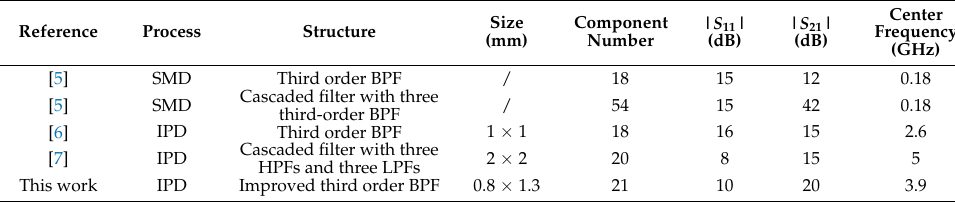
Table 3. Performance summary of proposed reflectionless band-pass